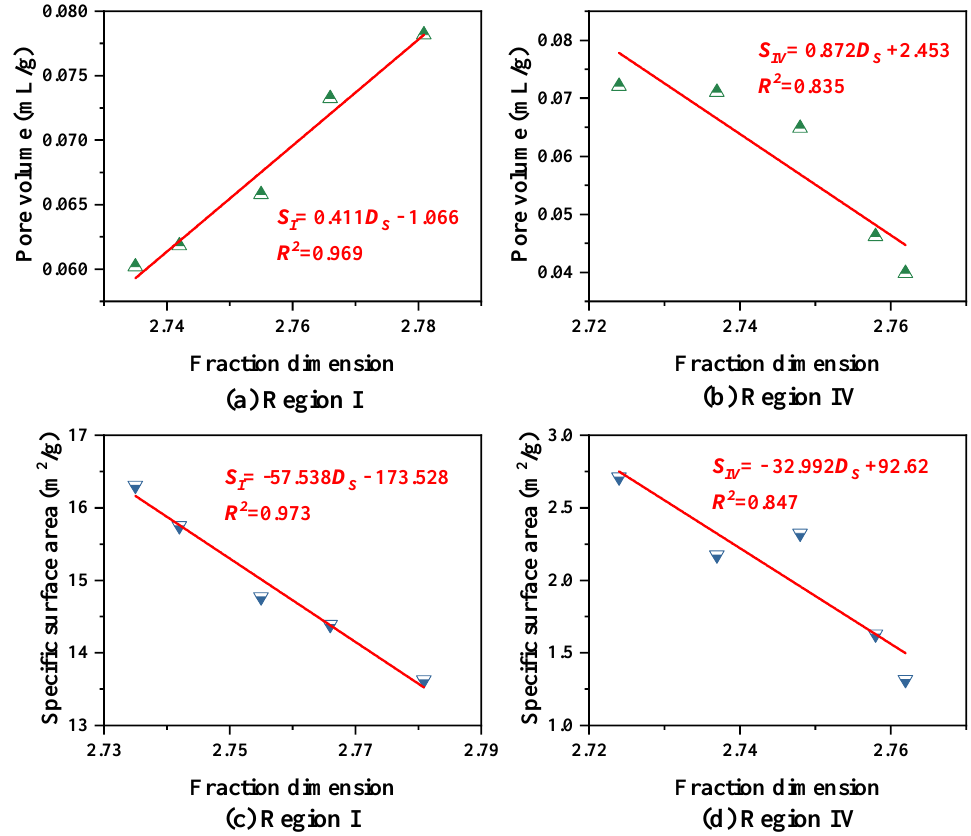
Figure 8. The correlation between fractal dimension and ( a , b ) pore volume and ( c , d ) specific surface area.